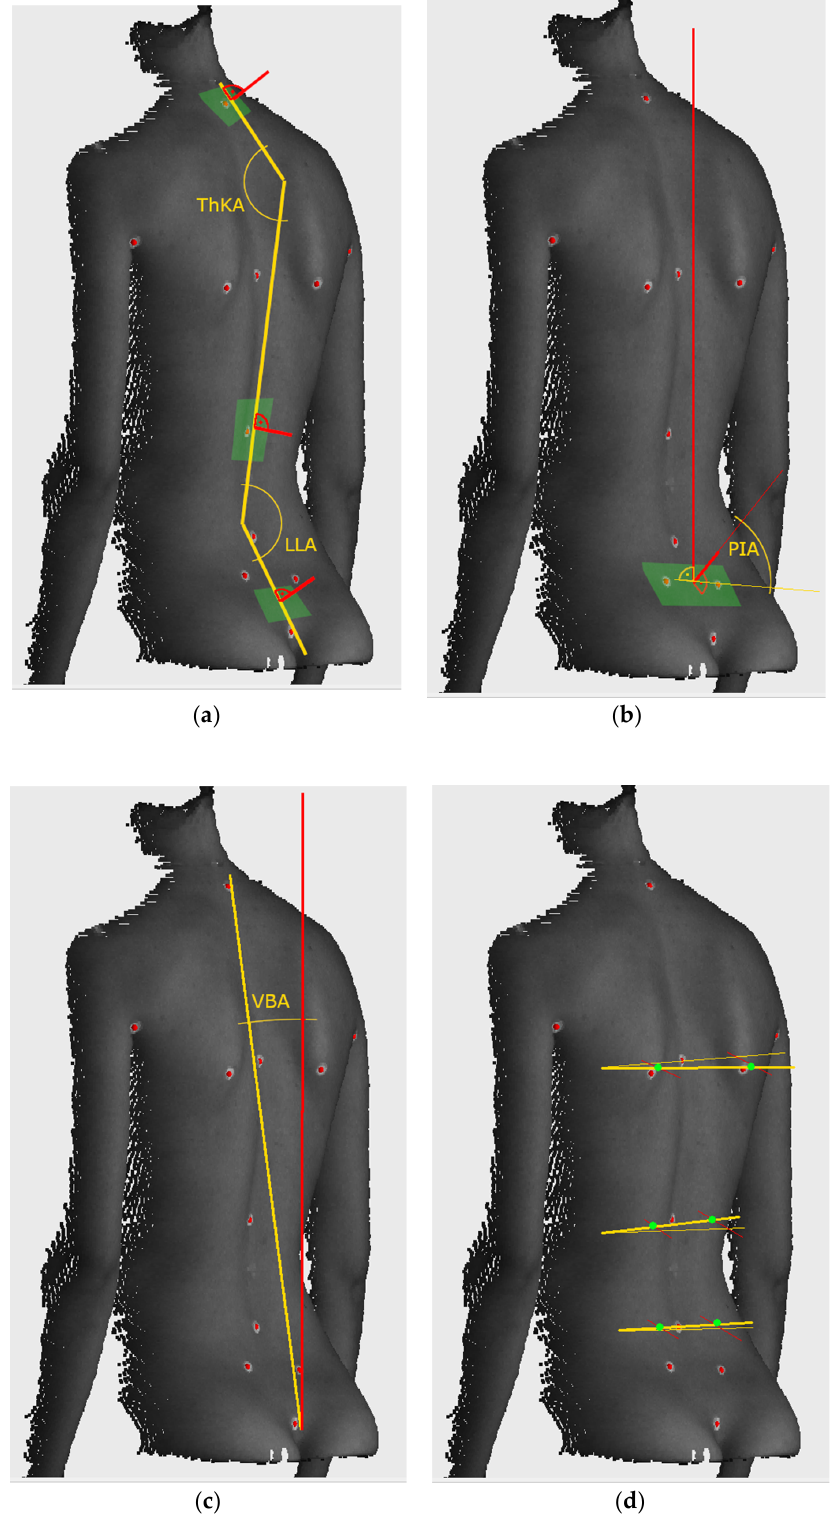
Figure 4. Calculation principle of parameters: ( a ) Cobb angles, ( b ) pelvis inclination, ( c ) vertical balance angle, ( d ) components of SHS. Green areas denote approximate parts of point cloud used for calculation. THKA: thoracic kyphosis angle, LLA: lumbar lordosis angle, PIA: pelvic inclination angle, VBA: vertical balance angle (vertical trunk inclination in the sagittal plane.